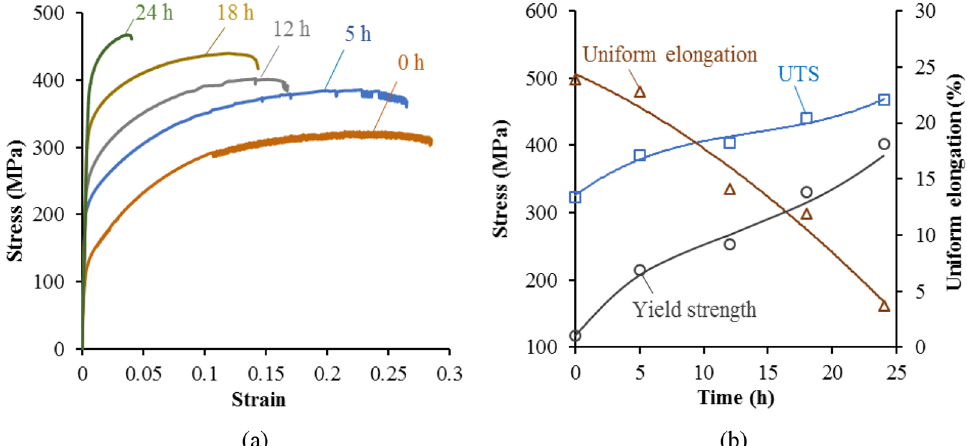
Fig. 4. (a) Tensile stress – strain curves of AA2050-WQ creep-aged under 150 MPa at 155 ° C with indicated durations and (b) evolutions of yield strength, UTS and uniform elongation of the creep-aged